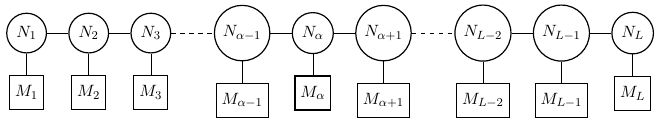
Figure 6 . A generic linear quiver with L gauge nodes.